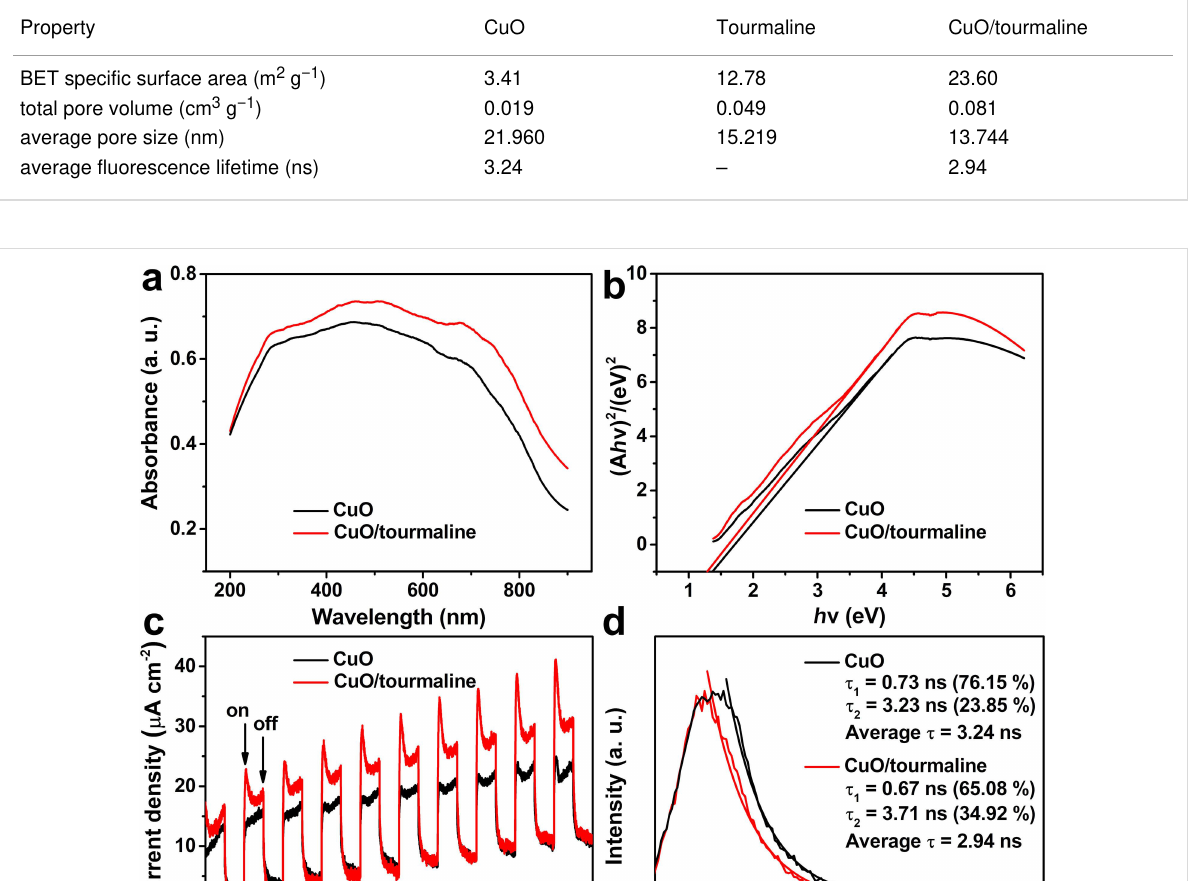
maline composite was calculated to be E g = 1.38 eV and E g = 1.31 eV, respectively (Figure 5b). The lower band gap of the CuO/tourmaline composite suggested a higher utilization efficiency of light